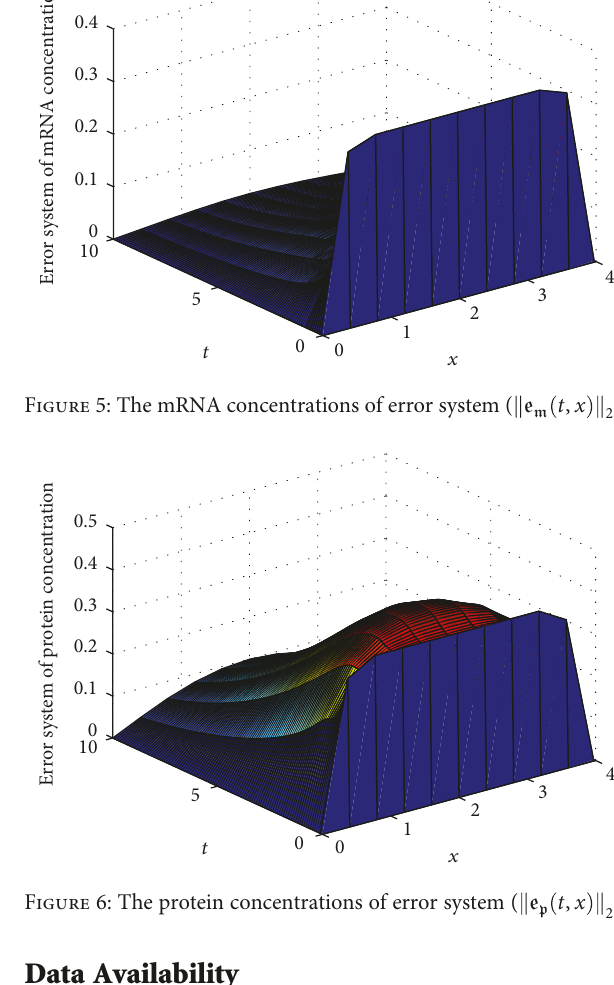
Figure 3: The estimation mRNA by the 1 -order observer ). ( ̂ m t , x 2